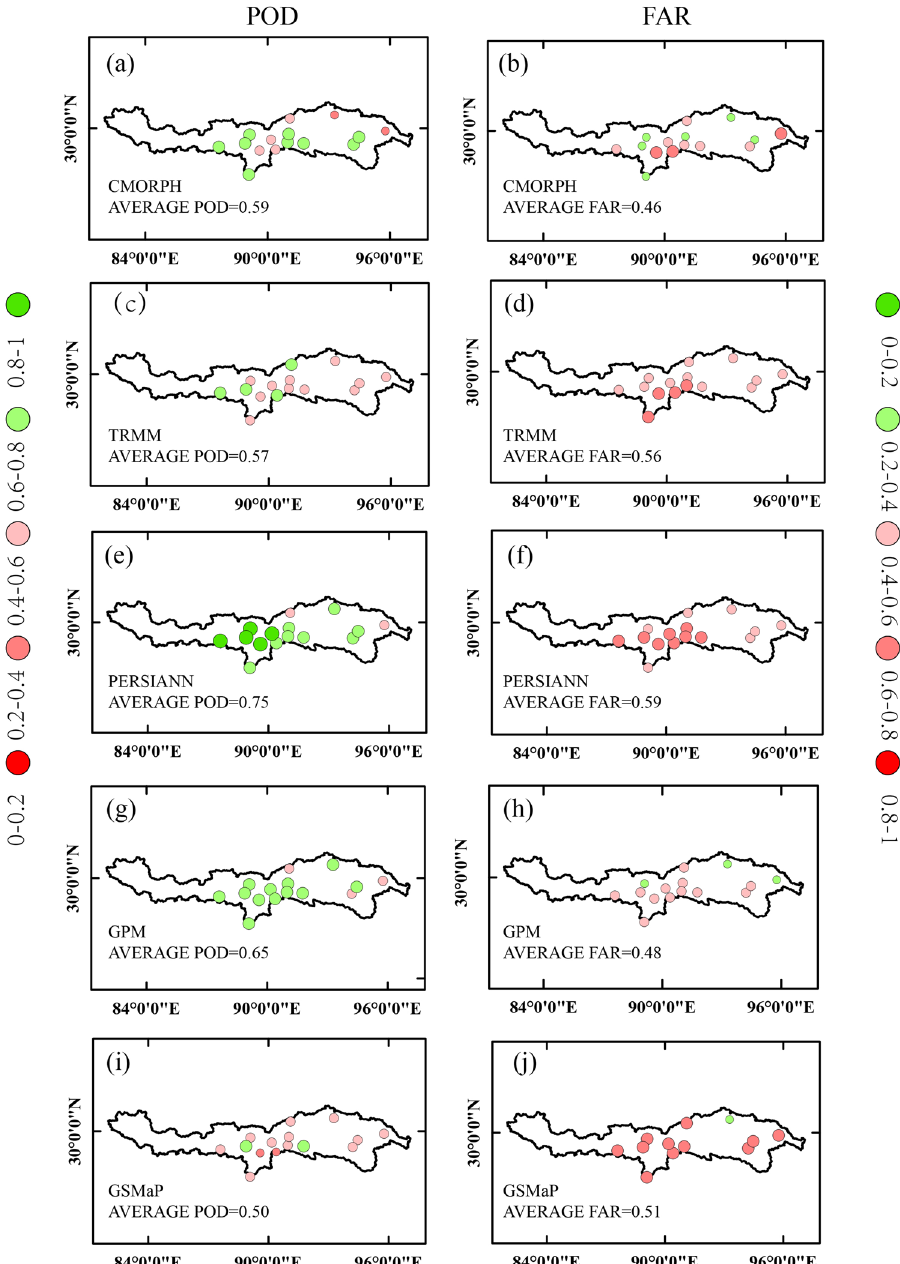
Figure 5. Spatial distribution of POD and FAR between SPPs and gauged